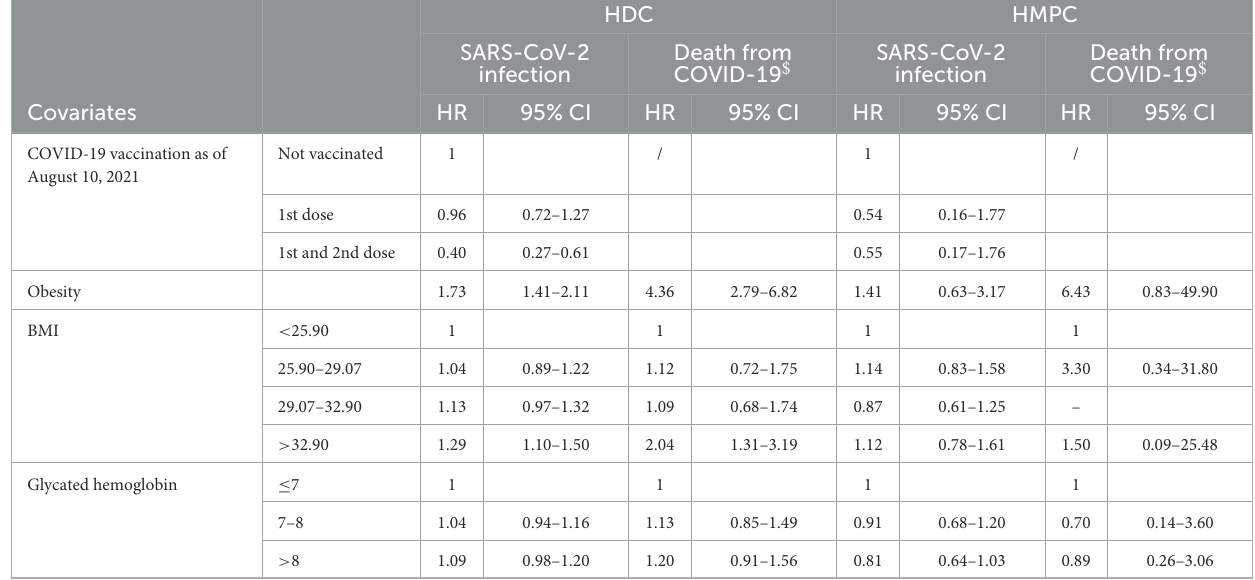
TABLE 4 Hazard ratios (HRs) of first infections of SARS-CoV-2 and deaths from COVID-19, in the population with Type-2 diabetes, by clinical characteristics, stratified by HDC and HMPC